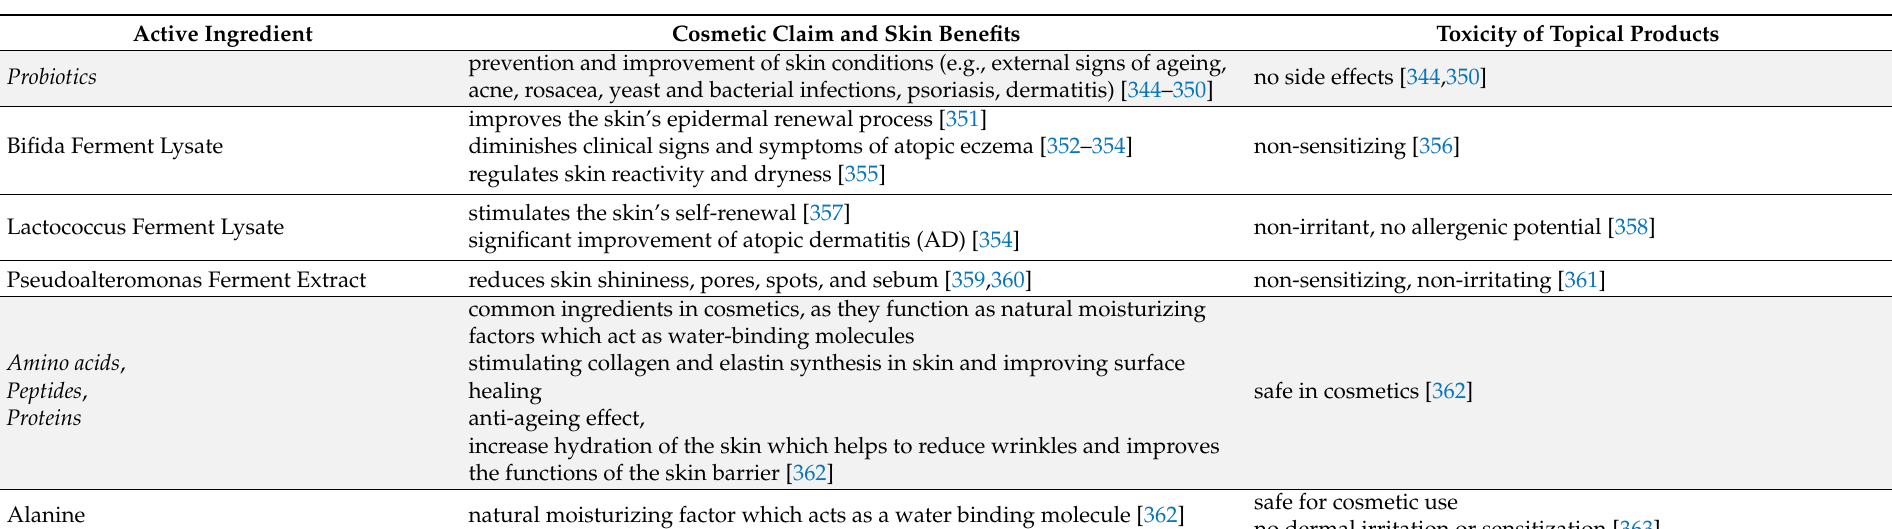
Table 3. Benefits, cosmetic claim, and toxicity of some active ingredients used in cosmetics together with hyaluronic acid and HA